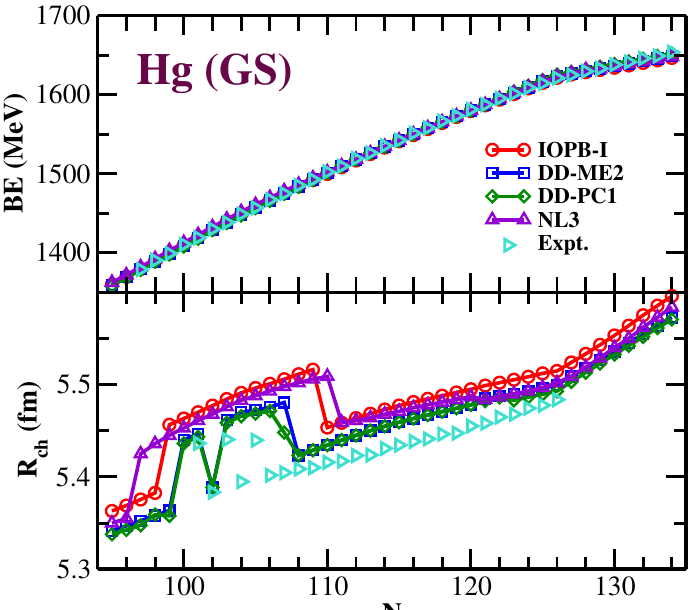
Figure 1. (Color online) The binding energy (BE) in MeV and charge distribution radius ( R ch ) in fm are shown for the ground state of Hg-isotopes along with the available experimental data [51,52].